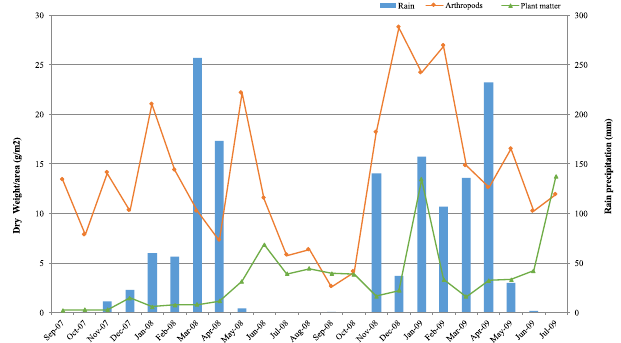
Figure 7. Arthropods availability (orange line), plant matter availability (green line), and rain precipitation (bars) during the research period.